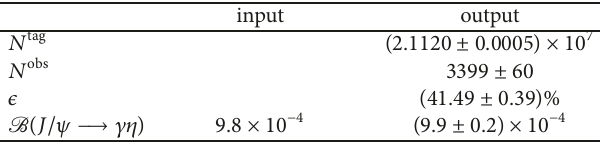
Table 2: The input and output